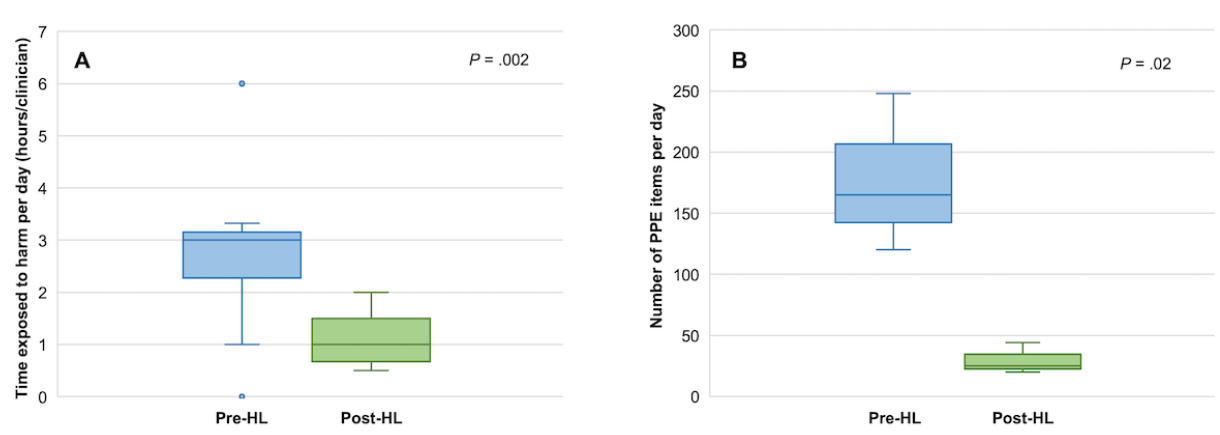
Figure 2. Aggregate data on staff exposure to risk and personal protective equipment (PPE) use across three clinical areas before and after HoloLens2 (HL) deployment. (A) Reduction in time (hours/day/staff member) exposed to high-risk coronavirus disease (COVID-19) environments (3.32 vs 1.63 hours, t =3.21, P =.002). (B) Reduction in the mean number of PPE items used (178 vs 30, t =3.88, P